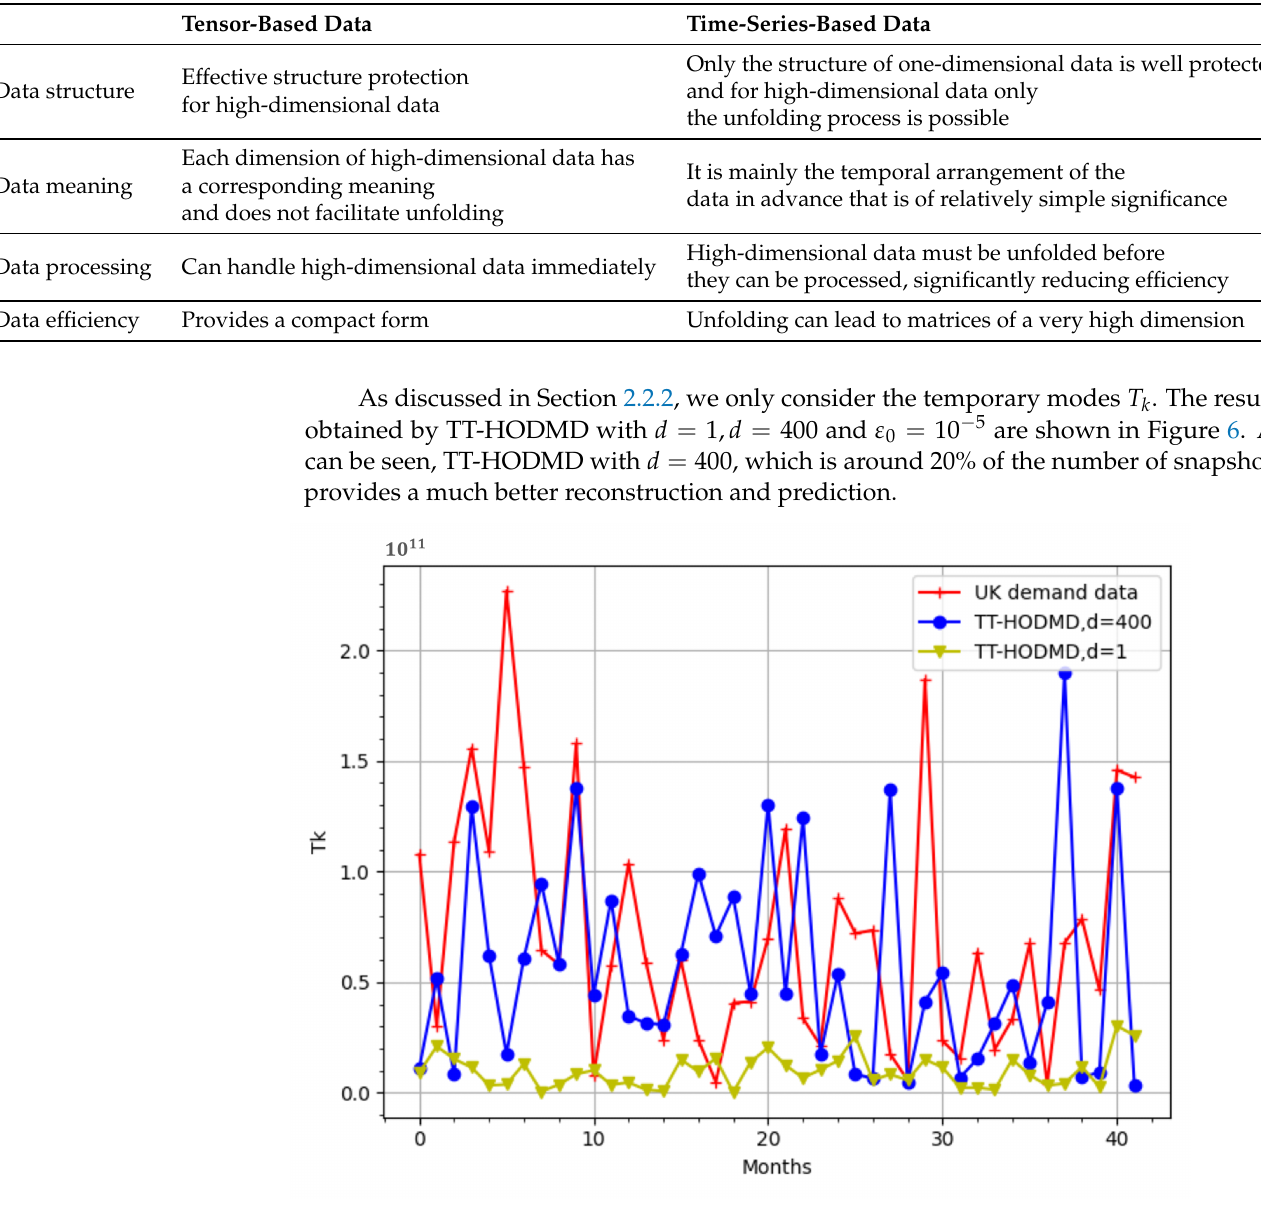
Table 2. The difference between tensor-based data and time-series-based data.